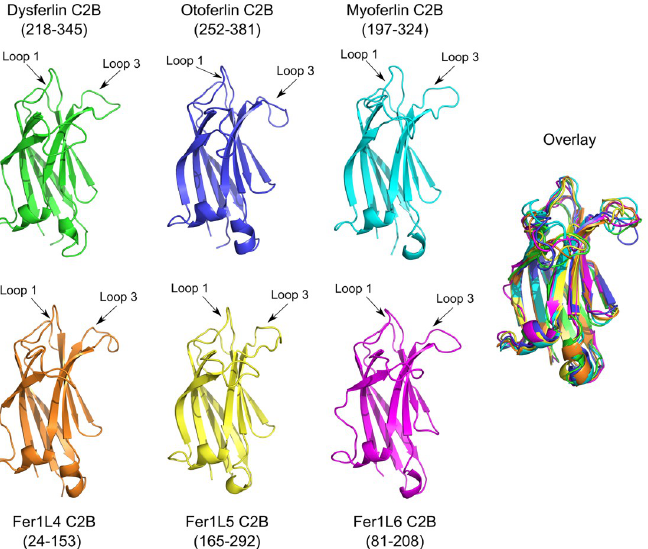
Fig 4. C2B models from dysferlin C2B (green), otoferlin C2B (blue), myoferlin C2B (cyan), Fer1L4 C2B (orange), Fer1L5 C2B (yellow), and Fer1L6 (magenta). Amino acid ranges for each domain are listed under the domain label. The superposition of all six C2B domains is labeled as